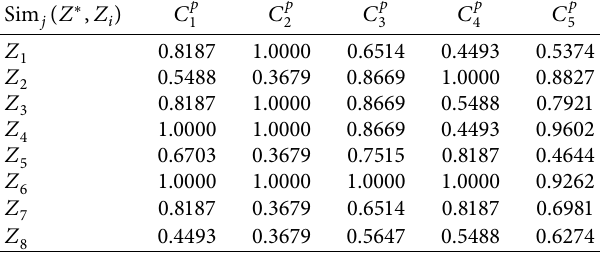
— — Table 2: Calculation results of problem characteristic